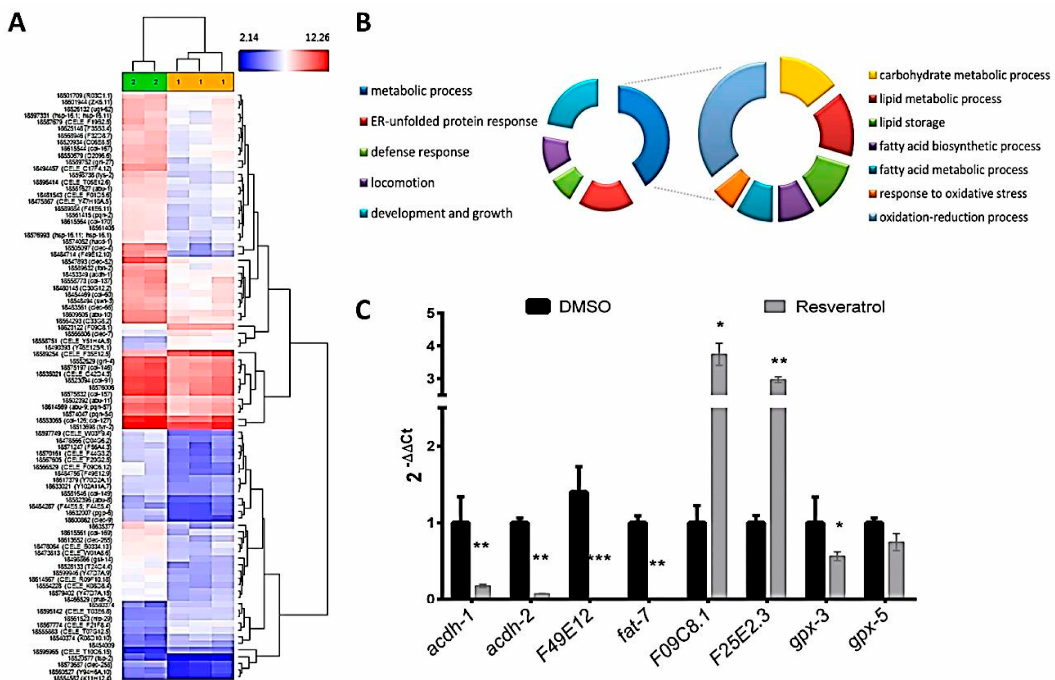
Figure 3. Comparison of the gene expression of resveratrol (200 µ M) vs. DMSO-treated worms. ( A ) Hierarchical clustering analysis of control (green) and resveratrol (yellow) samples. ( B ) Gene Ontology biological processes enriched in resveratrol-treated worms compared with DMSO. ( C ) qPCR analysis of genes di ff erentially expressed in microarray analyses. Results are expressed as the fold di ff erence expression levels of each gene in the resveratrol-treated group compared with the DMSO control group, calculated with the 2 − ∆∆ Ct method. Significance refers to the e ff ect of resveratrol with respect to DMSO control worms (Wilcoxon test, * p < 0.05; ** p < 0.01; *** p <